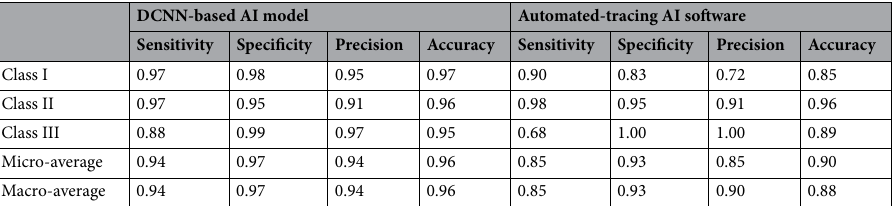
Table 4. Performances of cephalometric skeletal classification for DCNN-based AI model and automated- tracing AI software. DCNN, deep convolutional neural network.